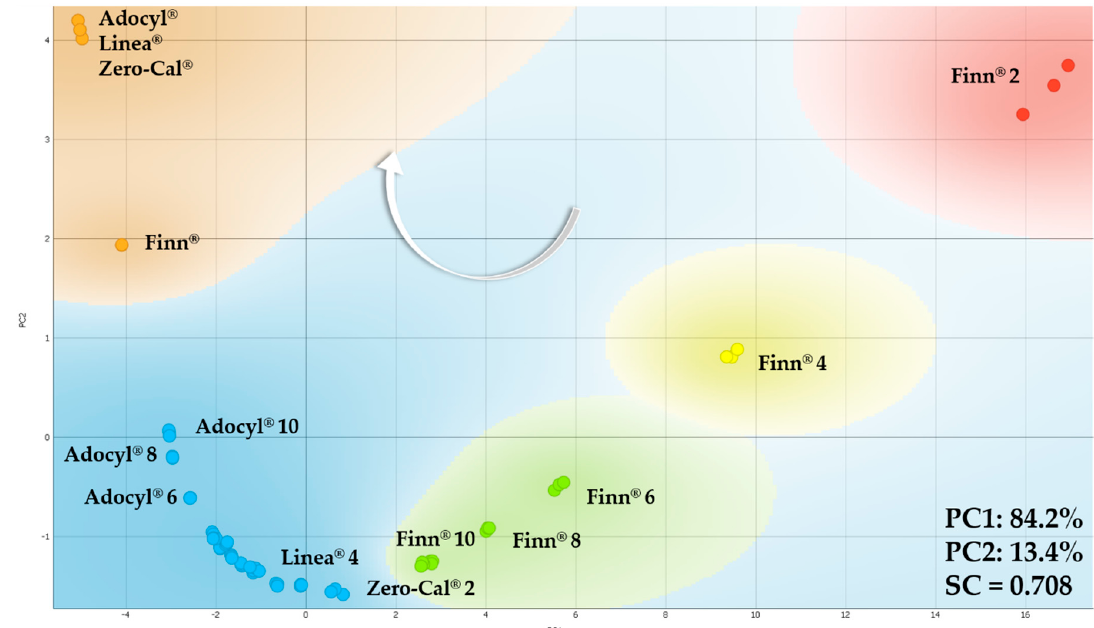
Figure 17. PCA plot for neat sucralose-based sweeteners and in aqueous solutions (from 2 to 10 µL/mL) obtained using the impedimetric microfluidic e-tongue at 5 mL/h flow rate. The number in front of the sweetener brand represents their respective solution concentration, while those without numbers represent the neat commercial sweetener. The white arrow indicates the direction of increasing concentration for all the brands tested.